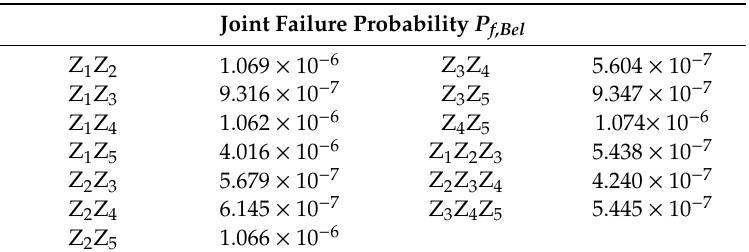
Table 5. Joint failure probability considering failure